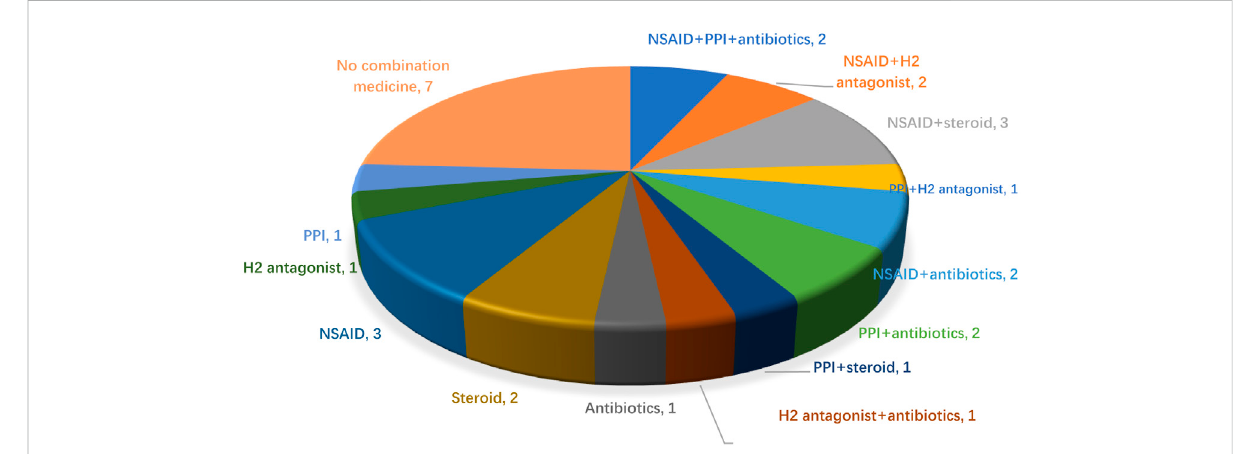
FIGURE 1 Patient concomitant medications before the third chemotherapy cycle.